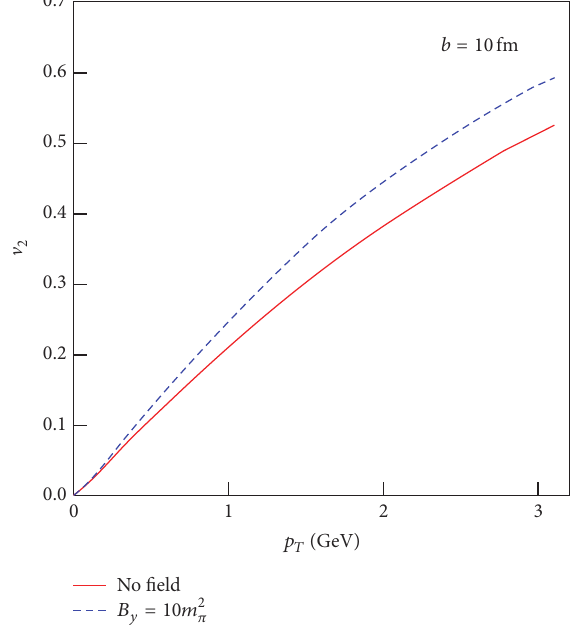
Figure 16: Elliptic flow of 𝜋 − as a function of 𝑝 𝑇 for 𝑏 = 10 fm Au- = 200 GeV. Red line corresponds to (2+1)D Au collisions at √𝑠 NN ideal hydrodynamics result without magnetic field; the blue dashed line corresponds to V 2 with external magnetic